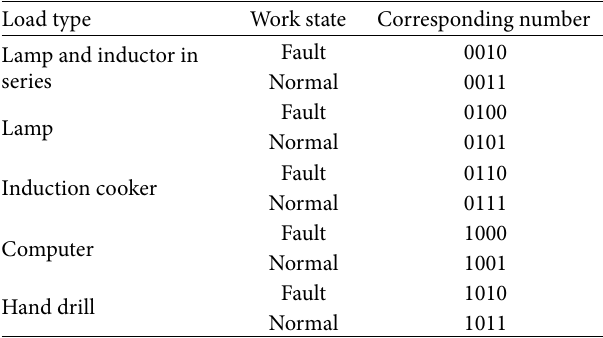
Table 7: Load corresponding number in different working condi-